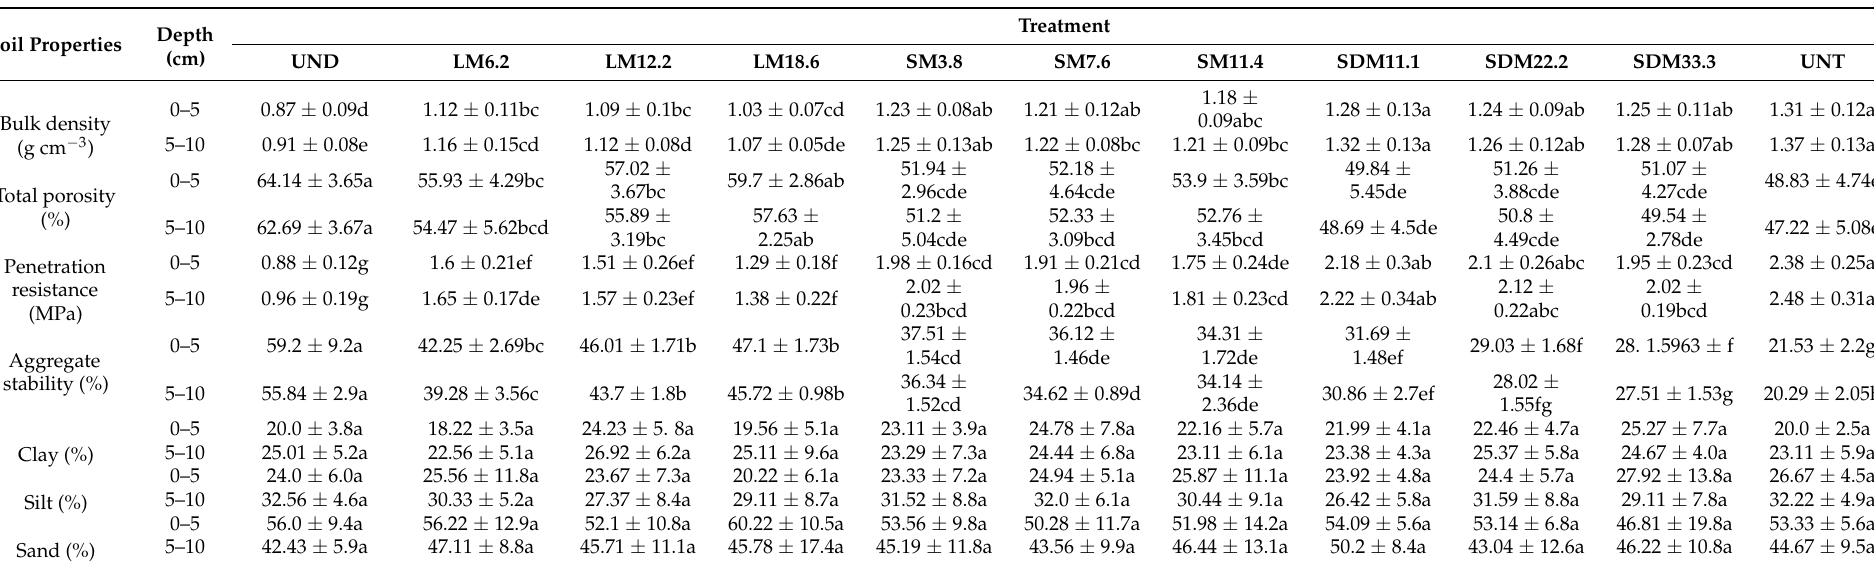
Table 2. Mean values ( ± SD) of different soil physical properties in different treatments. UND, undisturbed (control); LM6.2, litter mulch level of 6.2 Mg ha − 1 ; LM12.2, litter mulch level of 12.2 Mg ha − 1 ; LM18.6, litter mulch level of 18.6 Mg ha − 1 ; SM3.8, straw mulch level of 3.8 Mg ha − 1 ; SM7.6, straw mulch level of 7.6 Mg ha − 1 ; SM11.4, straw mulch level of 11.4 Mg ha − 1